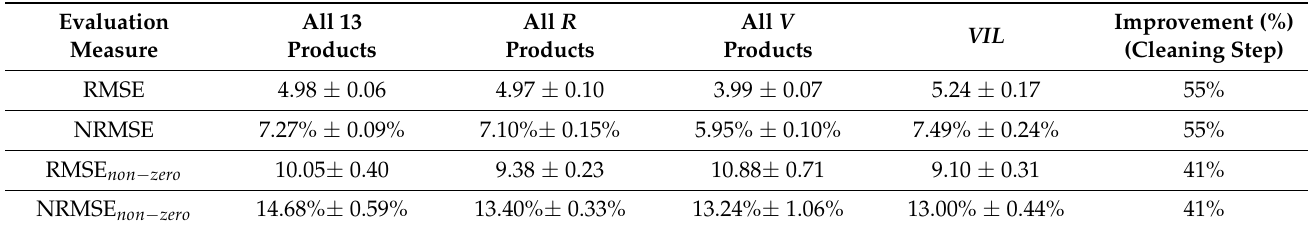
Table 2. Experimental results obtained using NowDeepN on the uncleaned data. 95% CI are used for the results. The last column illustrates the improvement achieved applying NowDeepN on the cleaned data, considering all 13 radar